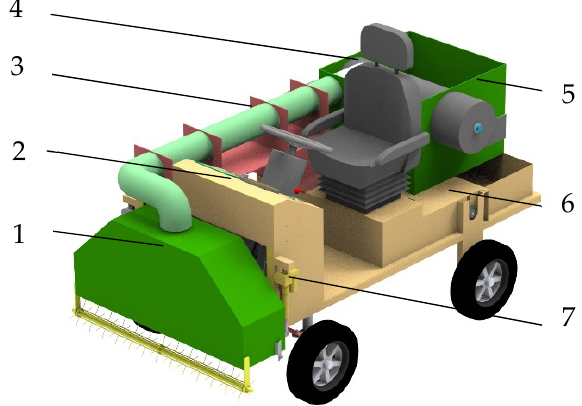
Figure 1. The three-dimensional (3D) structure of the harvester. 1. Collection devices; 2. Central control board; 3. Transmission pipeline; 4. Separation devices; 5. Seed storage tank; 6. Rack; 7. Height-regulating device. Table 1. Parameters table of dandelion seed harvester.